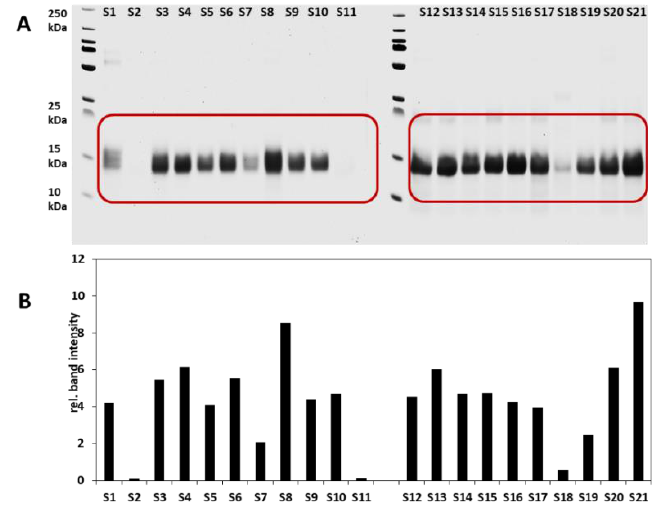
Figure 3. Sodium dodecyl sulfate-polyacrylamide gel electrophoresis (SDS-PAGE) with Coomassie Brilliant Blue R-250 staining of German wheat samples ( A ) and band intensity as relative protein content of the extracted ATIs ( B ). The marked region includes the bands between 10–20 kDa. 1–5; 6–10, and 11–15 represent the fractions whole-meal flour, centrifuged flour, passage flour, grain bran, and sling bran of the Julius , Ponticus , and Elixier cultivars, respectively. Samples 16 to 25 represent the extracts from A. bayernkönig , Julius 2017IRGT reformIFindus , Nordkap , Patras , Ponticus 2017 , Kerubino , Tobias , and Capo , respectively.